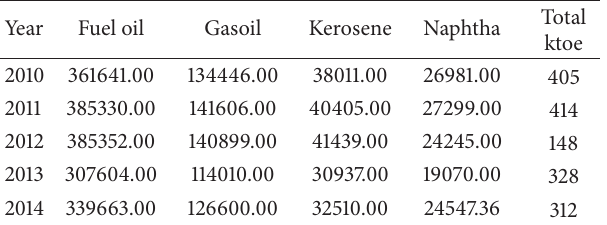
Table 9: Oil production.